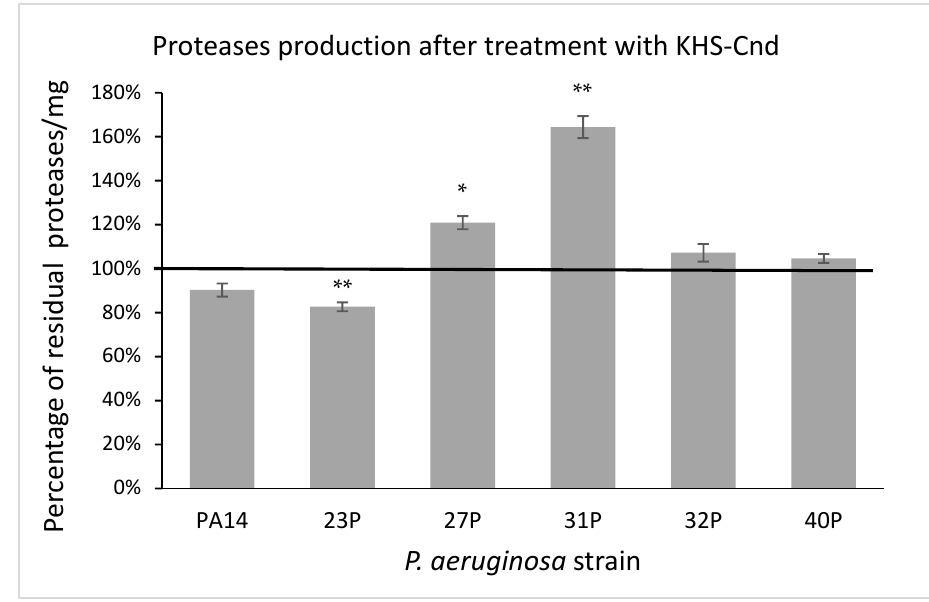
Figure 8. Effect of KHS-Cnd on the protease production of different clinical strains and PA14 reference strain. Data are expressed as the percentage of residual proteolytic activity after 24 h treatment with 40 µ M KHS-Cnd (except for 32P where 20 µ M KHS-Cnd was used) compared with the untreated control bacteria. Error bars indicated the standard deviations of all of the measurements. Statistical difference was determined by the Student’s t -test: * p < 0.05; ** p < 0.01 compared with the